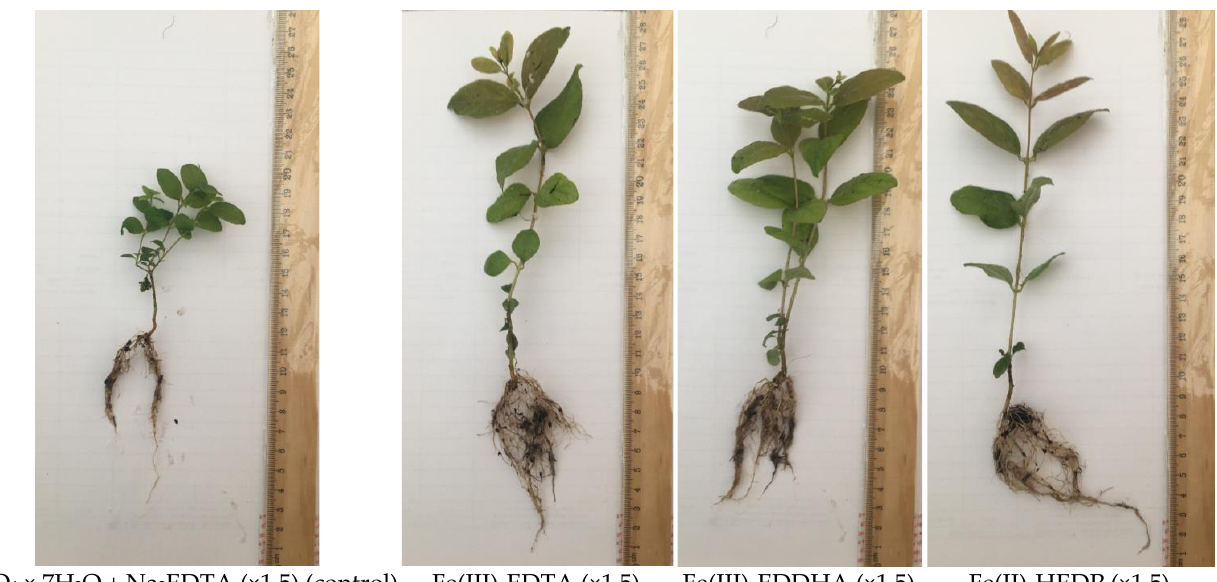
Figure 5. Blue honeysuckle “Lulia” ( Lonicera caerulea var. kamtschatica Sevast.) plants at the end of the stage of acclimation to nonsterile conditions depending on the iron chelate type at an increased concentration (×1.5) in the MS nutrient medium at the stage of rooting.